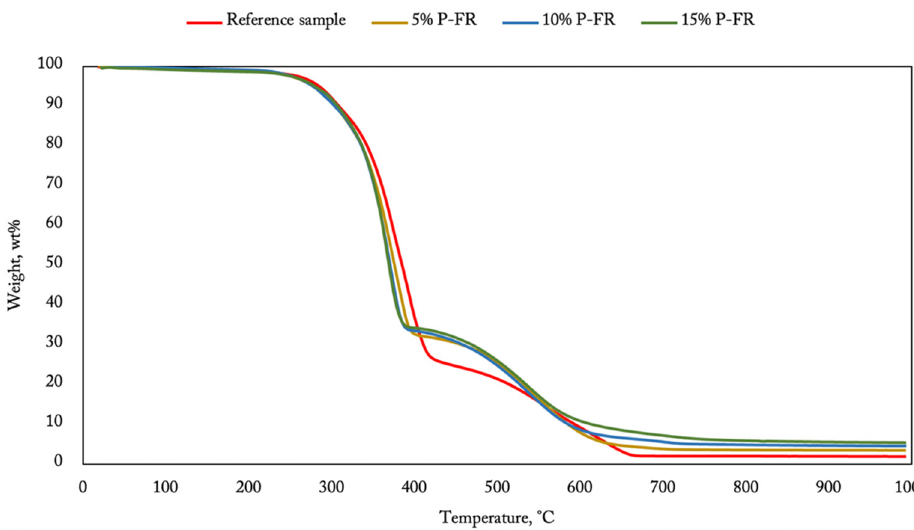
Figure 7. TGA of polyurea–polyurethane coatings containing aluminum hydroxide.